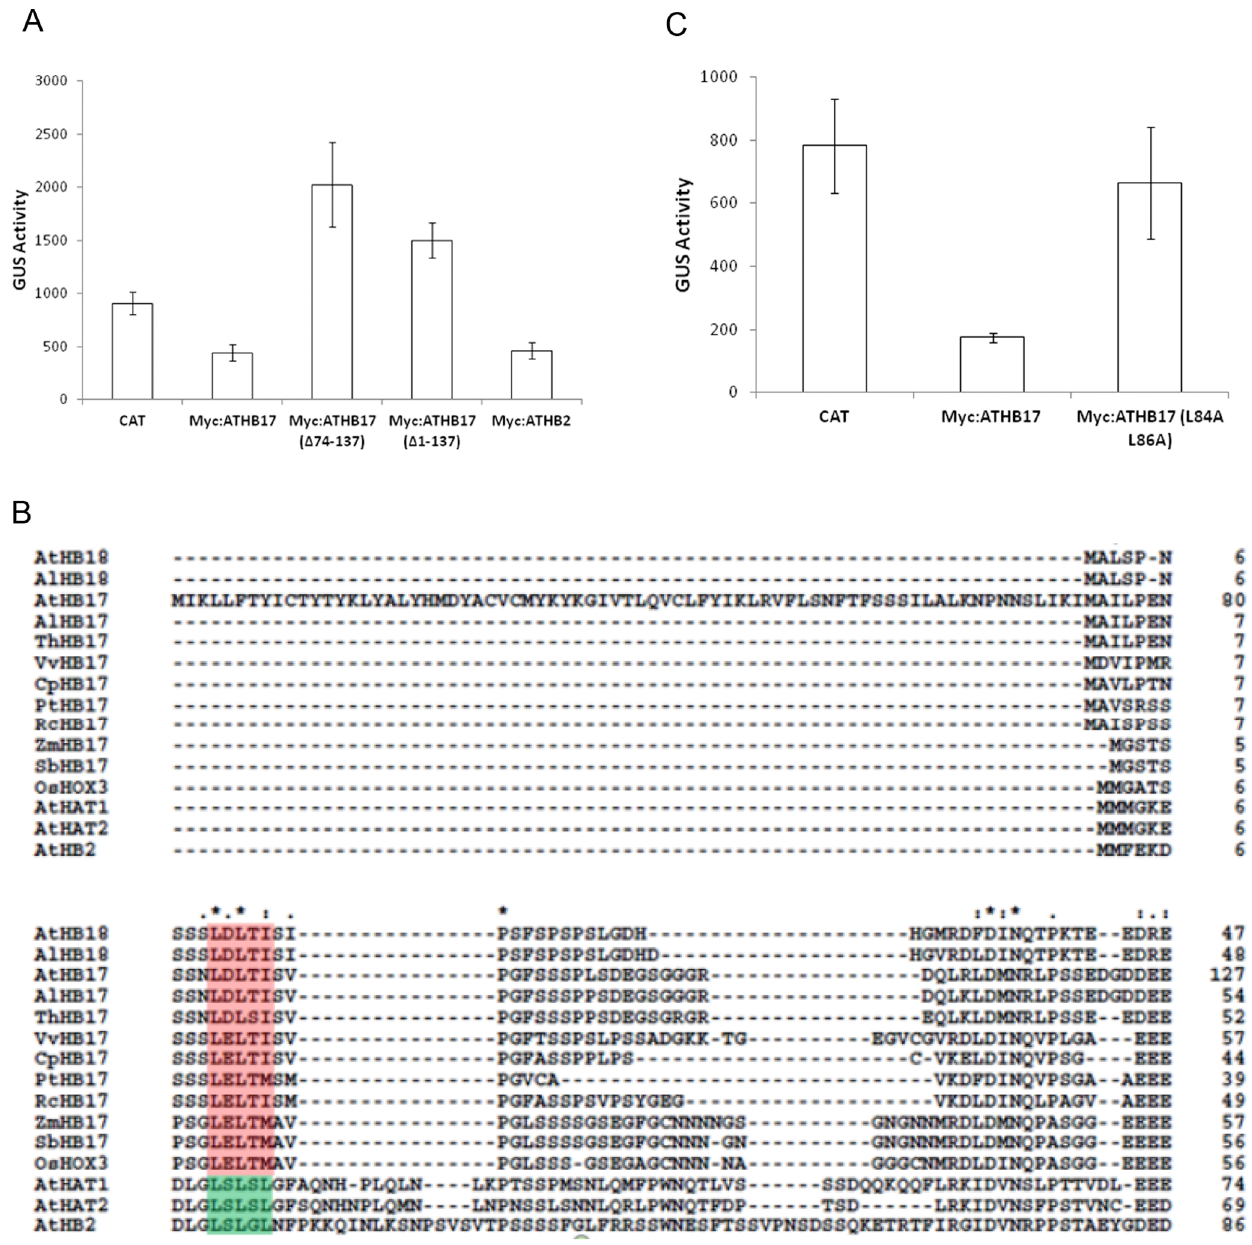
Figure 3. Effect of various mutations on the transcriptional repression and identification of EAR-like motif. (A) Arabidopsis mesophyll protoplasts were co-transformed with the pHAT1 :: GUS reporter gene and the following effector constructs: chloramphenicol acetyltransferase (CAT), ATHB17, ATHB17 with amino acids 74–137 deleted, ATHB17 with amino acids 1–137 deleted and ATHB2. Data are mean fluorescence readings measuring GUS-mediated substrate (4-methylumbelliferyl-beta-D-glucuronide) conversion. Error bars represent 6 SD of three replicates. (B) Multiple alignment of the protein sequences similar to the amino terminus of ATHB17 from publically available HD-Zip II a subfamily proteins. Gaps are indicated by dashes. A putative EAR motif is shaded in red for the a -subclass, while the EAR motif identified in [25] is shaded in green. Abbreviations for species are as follows: At Arabidopsis thaliana ; Al Arabidopsis lyrata ; Th Thellungiella halophila ; Vv Vitis vinifera ; Cp Carica papaya ; Pt Populus trichocarpa ; Rc Ricinus communis ; Zm Zea mays ; Sb Sorghum bicolor ; Os Oryza sativa . (C) ATHB17 , ATHB17 with the EAR motif mutated (ATHB17 L84A L86A), or CAT effector constructs were co-transformed into Arabidopsis mesophyll protoplasts with the pHAT1 :: GUS reporter gene. Data are mean fluorescence readings measuring GUS-mediated substrate (4-methylumbelliferyl-beta-D-glucuronide) conversion. Error bars represent 6 SD of three replicates.